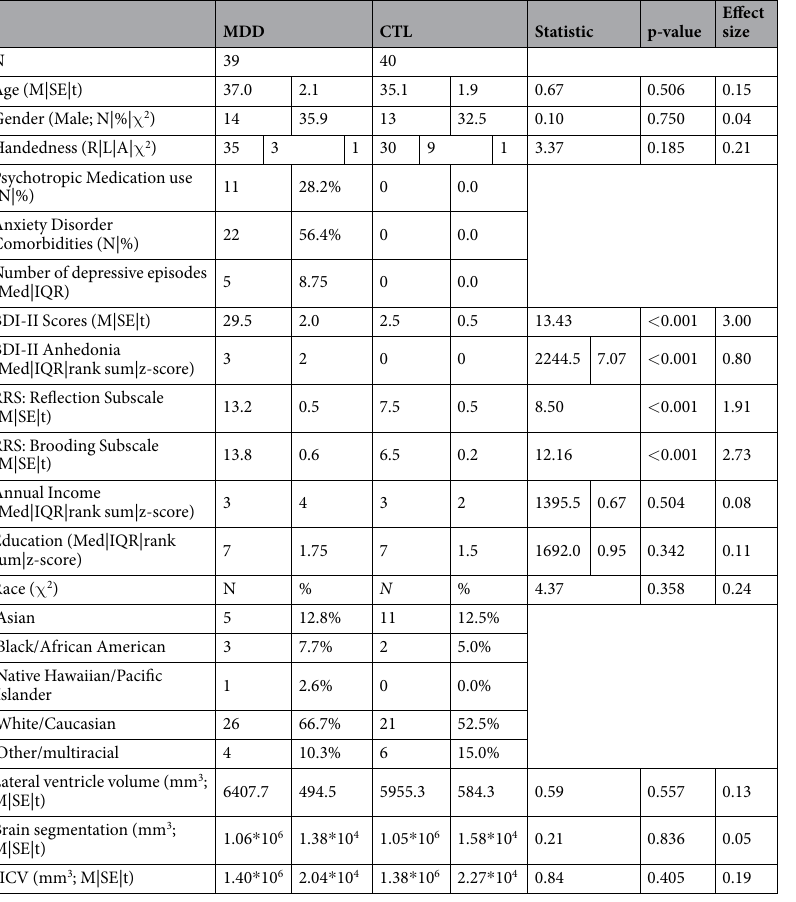
Table 1. Participant characteristics. Number of depressive episodes was set to 10 when participant indicated non-specific large values (e.g., “too many to count”). Income was coded from 0 to 5 ( < $10,000;